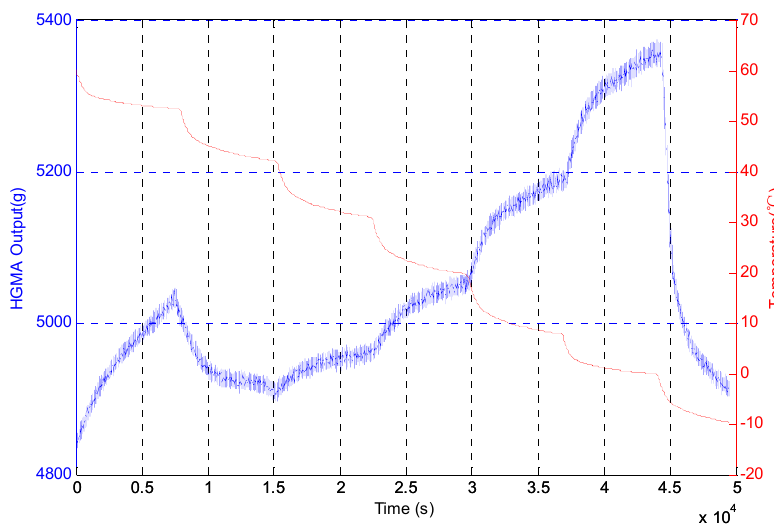
Figure 10. The output of MEMS in the temperature experiment.